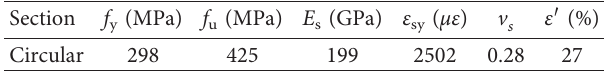
Table 1: The material properties of steel tube used in experiment.